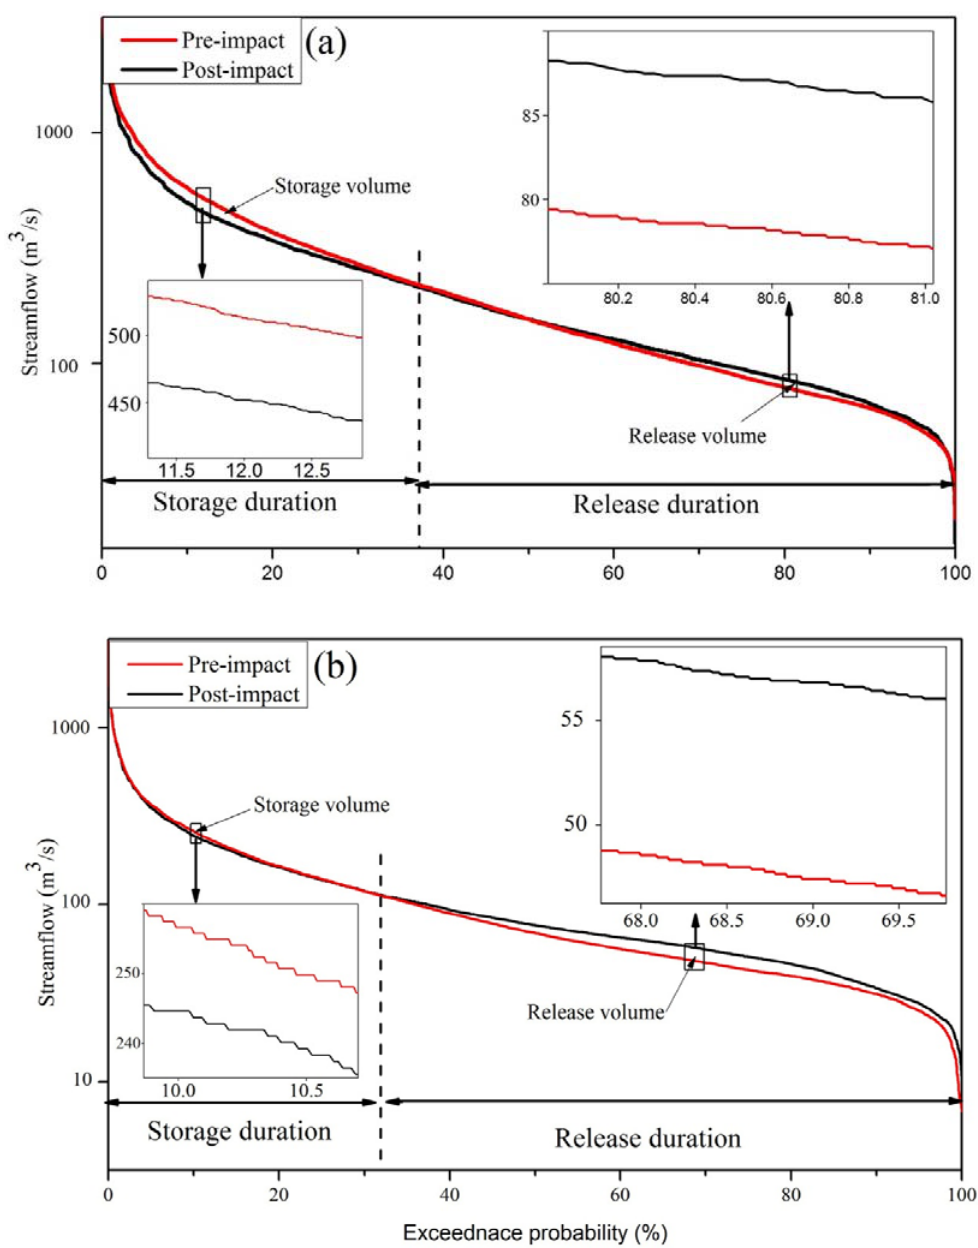
Figure 4. The flow duration curve change in JRW ( a ) North River reach; ( b ) West River reach.